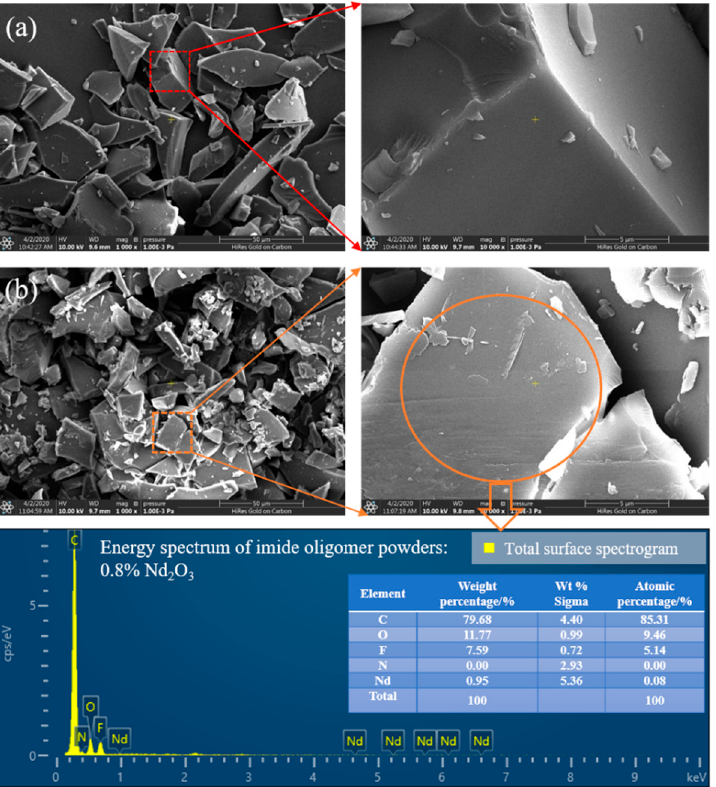
Figure 5. The SEM pattern of the imide oligomer powders: ( a ) control and ( b ) 0.8% Nd 2 O 3 .